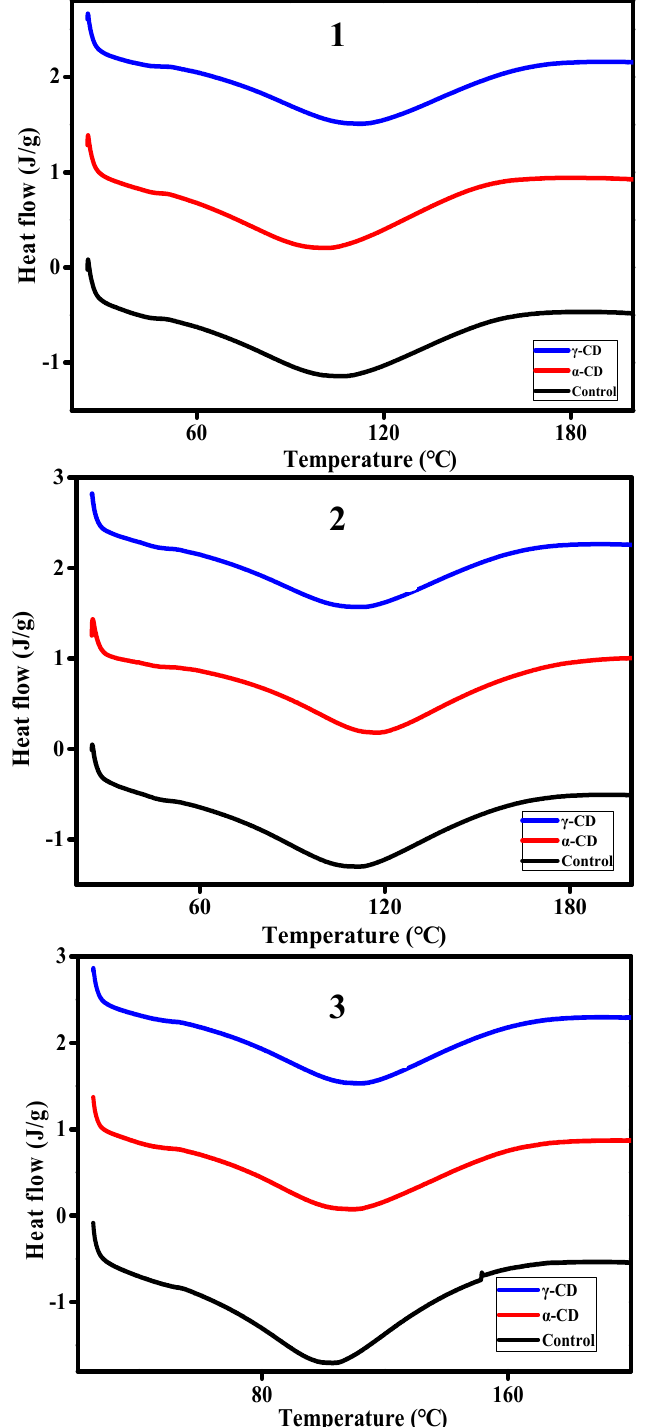
Figure 6. Typical DSC test curve of prebaked bread samples in the control, 2.0 wt% α -CD, and 3.0 wt% γ -CD groups that had been frozen for 1(1), 2(2), or 3(3) weeks.